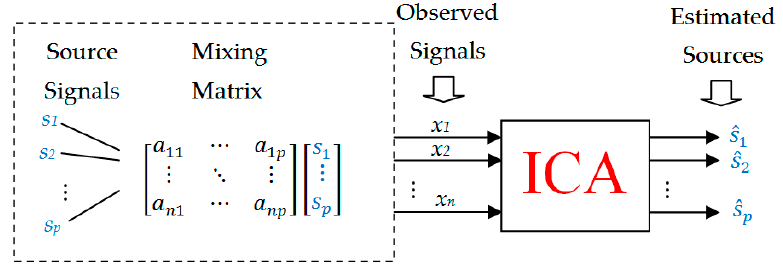
Figure 1. Block diagram of standard independent component analysis.